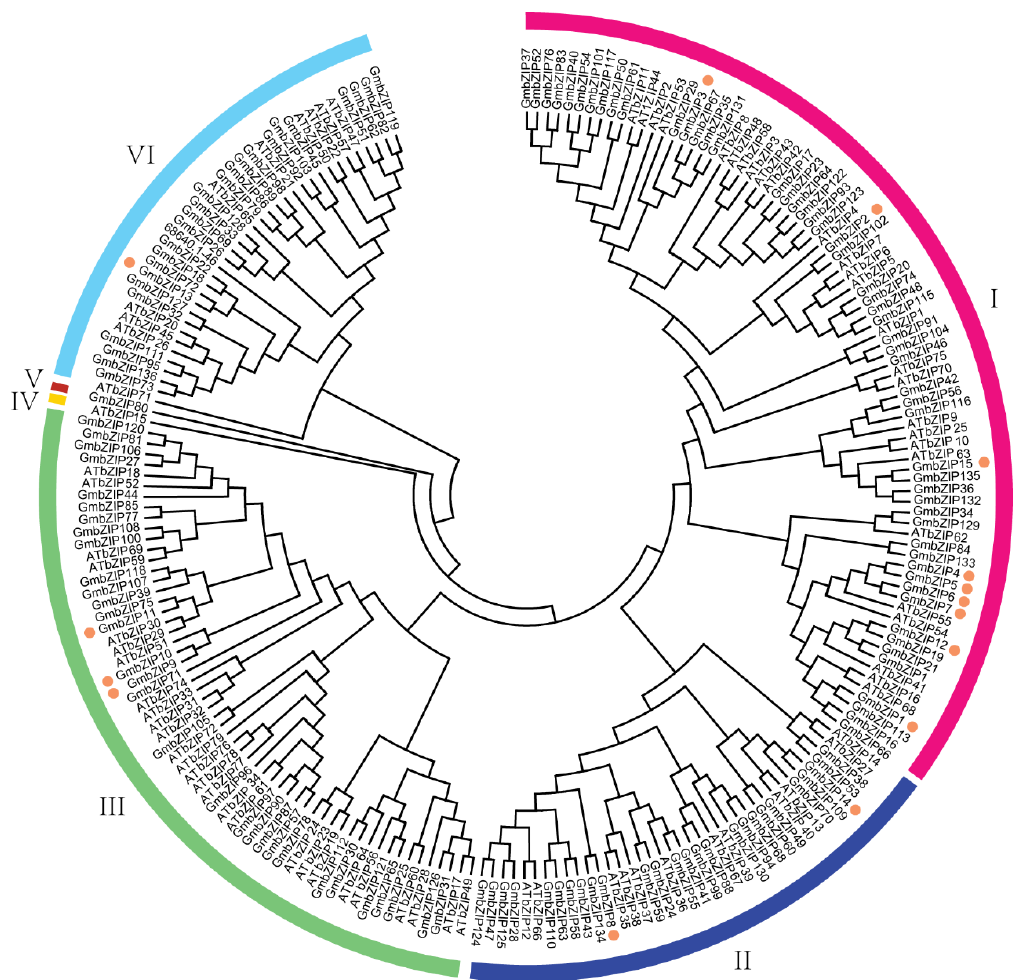
Figure 1. Phylogenetic relationships of bZIPs with soybean and Arabidopsis thaliana . The phylogenetic tree was produced by MEGA 5.0 software based on the comparison of amino acid sequences of GmbZIPs. The neighbor-joining method was used and the bootstrap values were set at 1000. The brown dot means GmbZIP s that were high induced in transcriptome data (Table S1). GmbZIP s were divided into six classes.